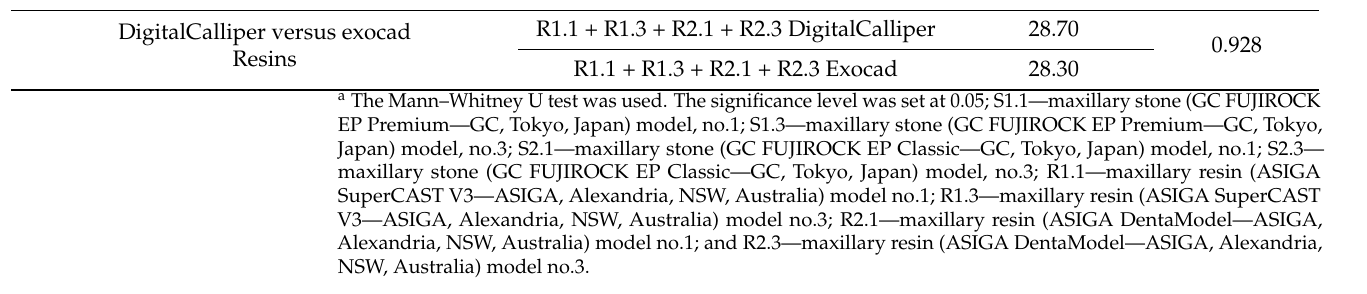
Table 3. Mandibular pairwise comparison of the 14 studied diameters using the Mann–Whitney U test. Pairwise Comparison Mean Rank p -Value